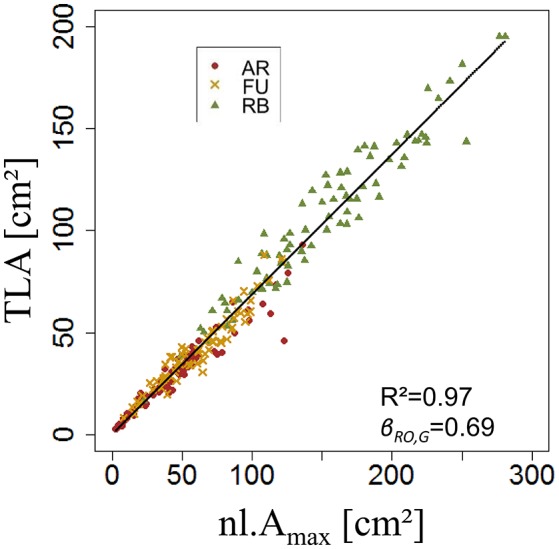
Parameterization of βRO,G (N = 232 rosettes).